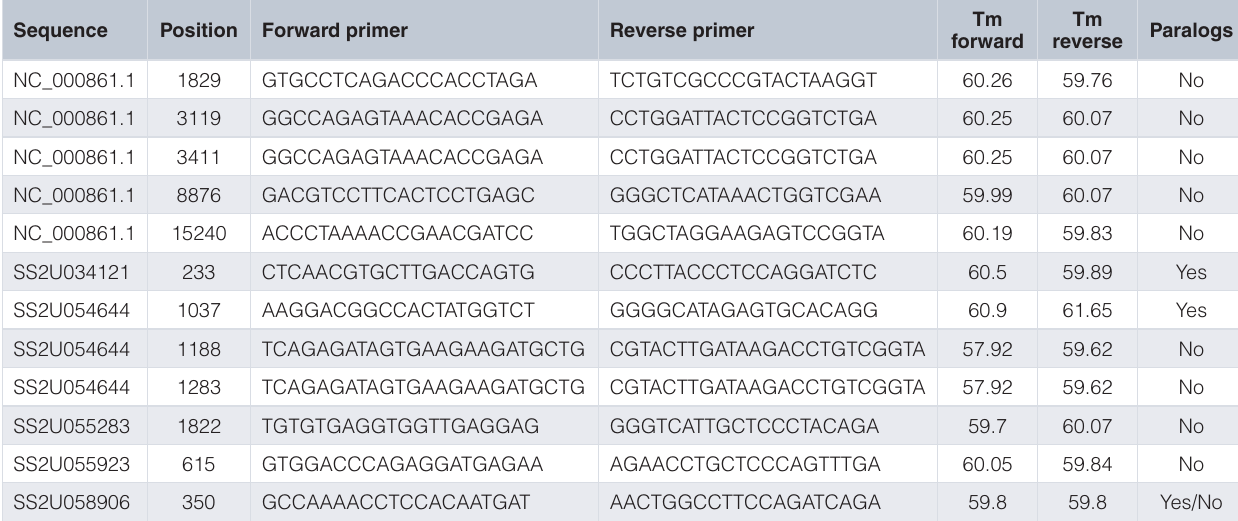
Supplemental Table S2 A. Verification of candidate polymorphisms. Primer sequences, melting temperatures and primary